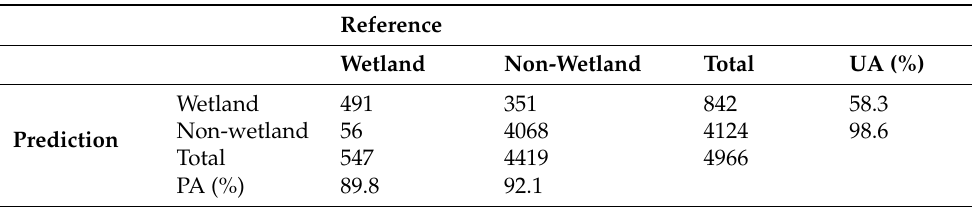
Table 2. Estimated error matrix for the final classification with estimates for the user’s accuracy (UA) and producer’s accuracy (PA). Reference Wetland Non-Wetland UA (%) Prediction